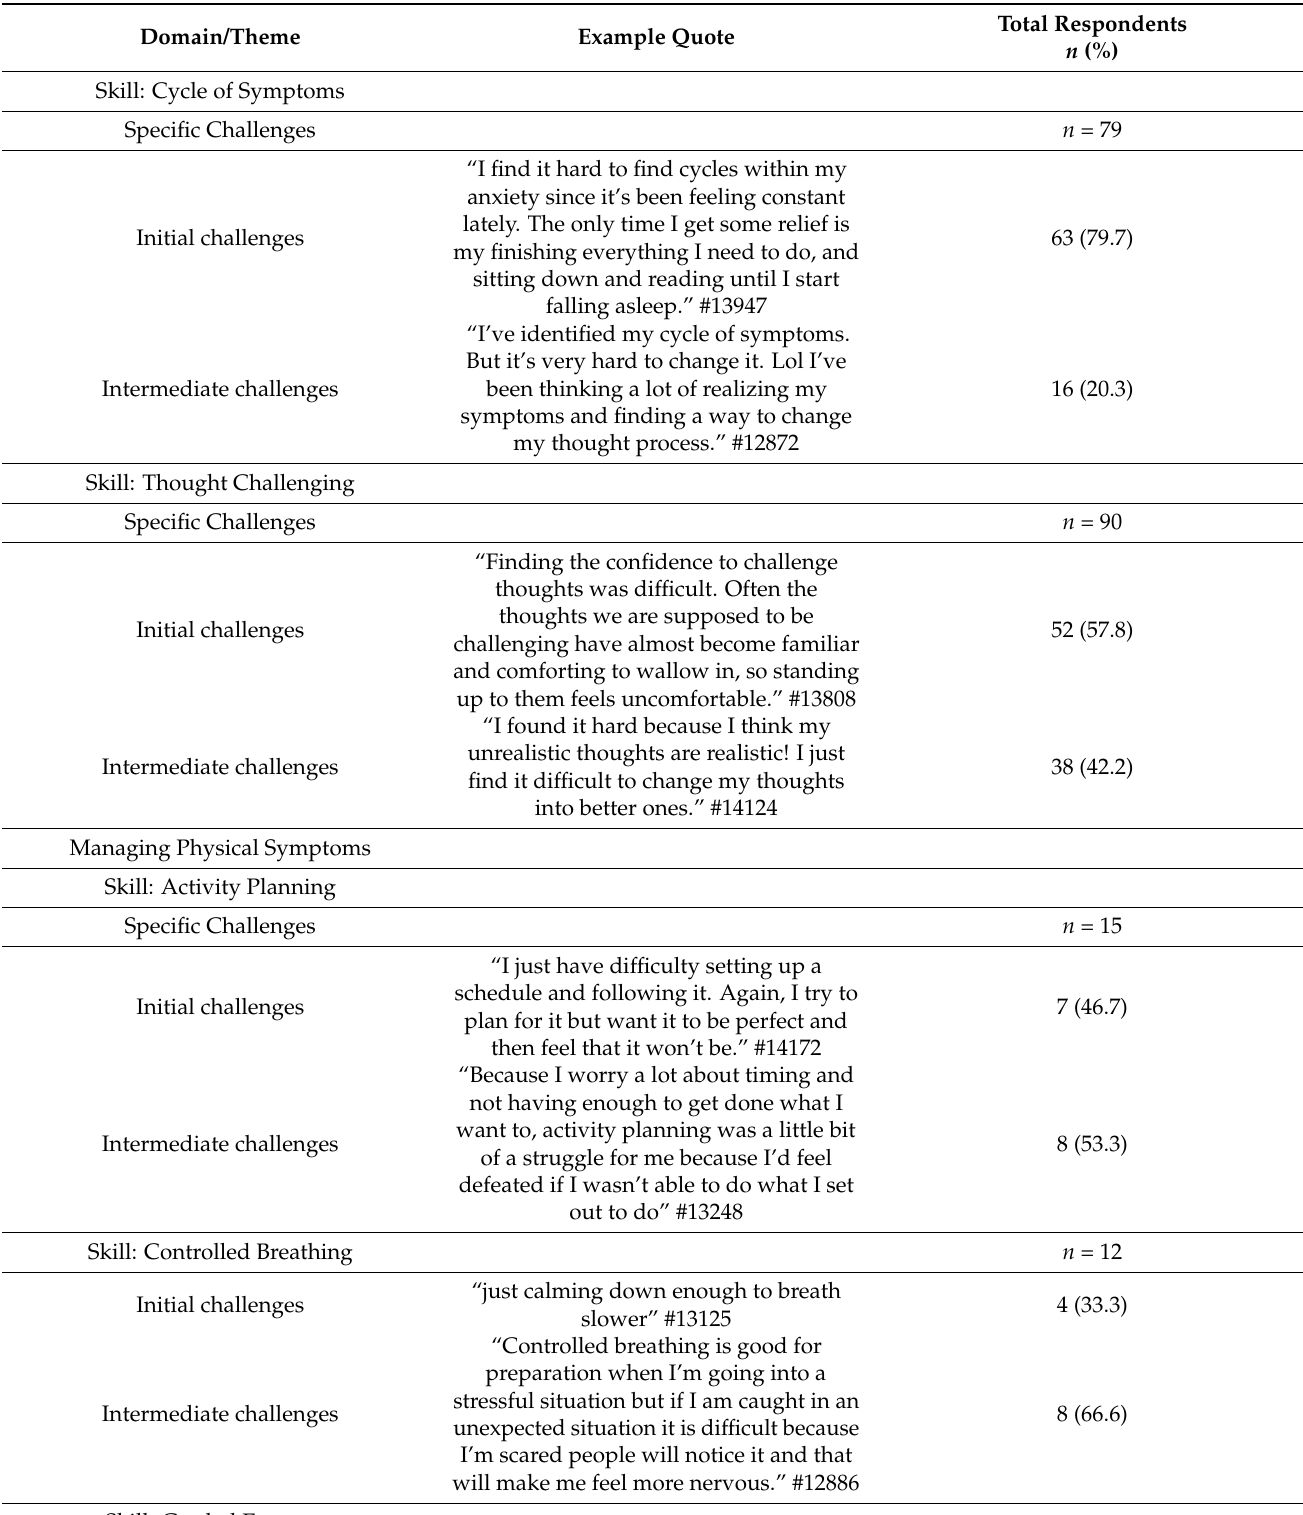
Table 3. Skill-specific